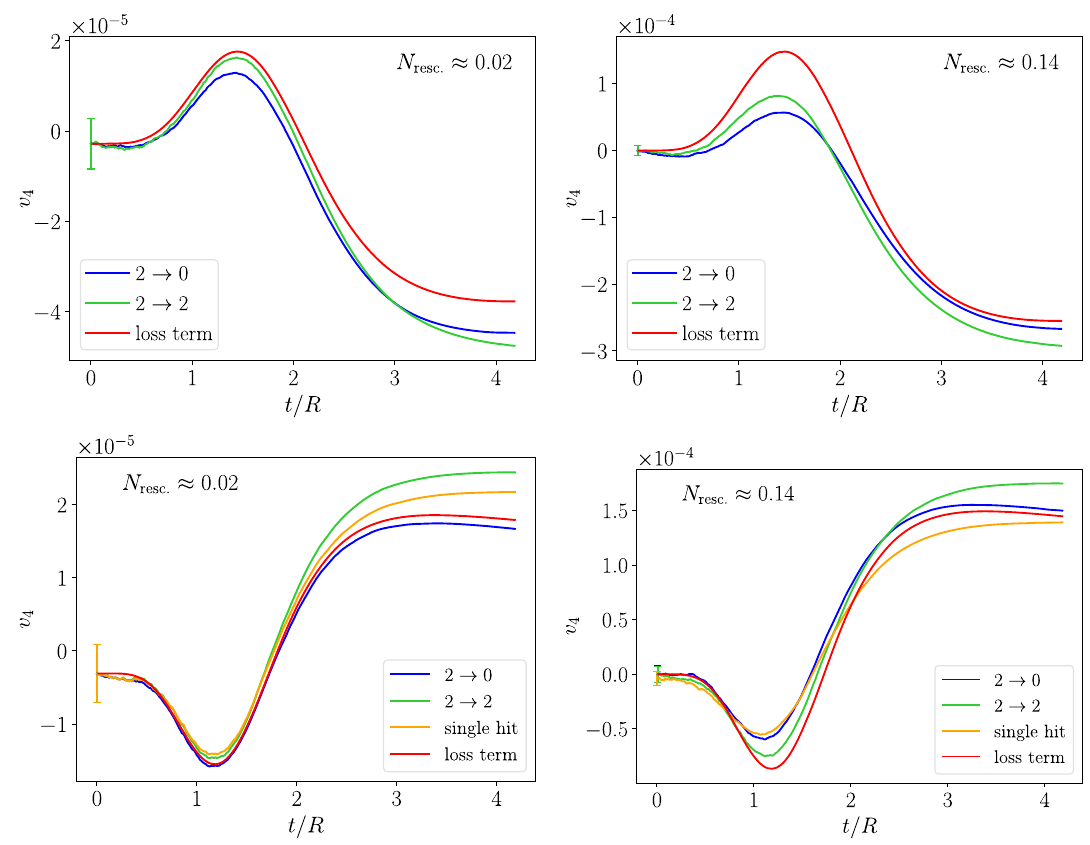
= 0. Green: systems with elastic binary scatterings; blue: 2 → 0 ε 4 kernel; orange: single-hit model; red: analytical results (16) (top) or Eq. (17)